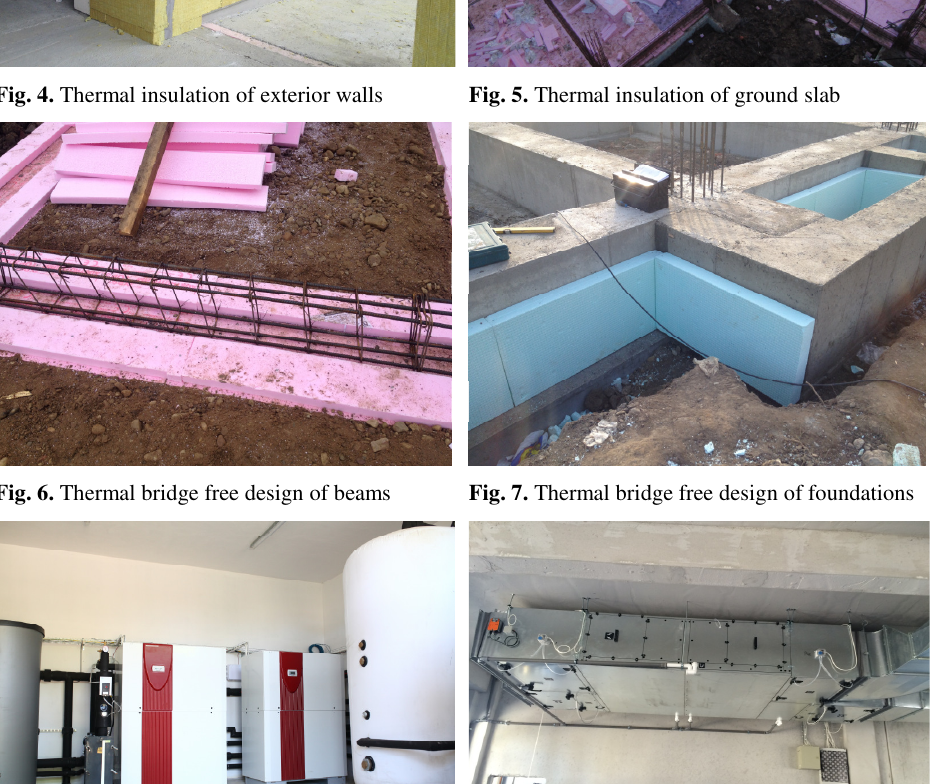
Fig. 3. Global cost analyis